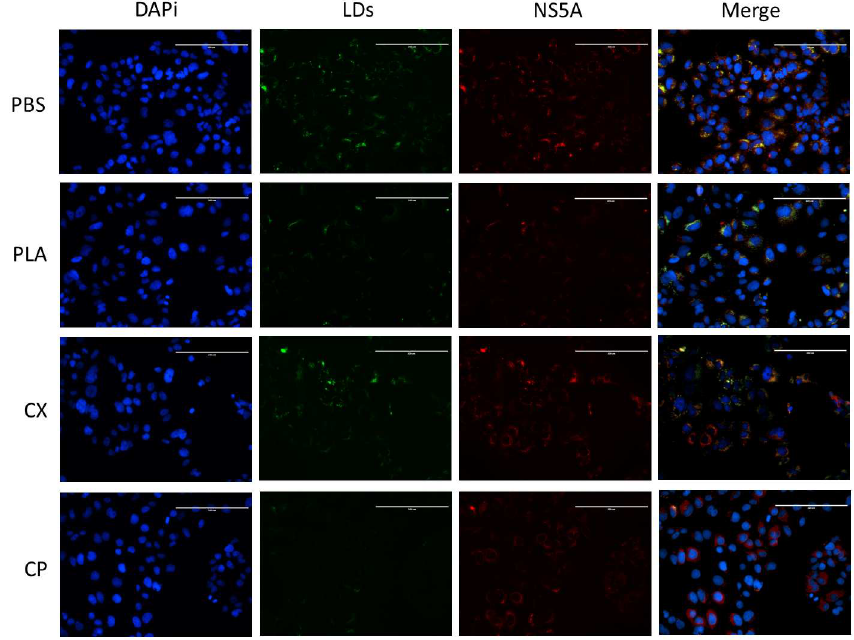
Fig 9. Effect of toxins on lipids droplets. Huh-7.5cell line stably expressingSGR-luc-JFH-1 were treated with 10 μ g/mL of CX, CP or PLA 2 -CB at 37˚ for 48 hours. Cell were fixed and nuclei,Lipid droplets (LDs) and viral protein NS5A were labelledwith DAPi (blue), BODYPI 493/503(green) and antibodies againstNS5A (red), respectively.PBS was used as untreatedcontrol. Scale bars, 200 nm.